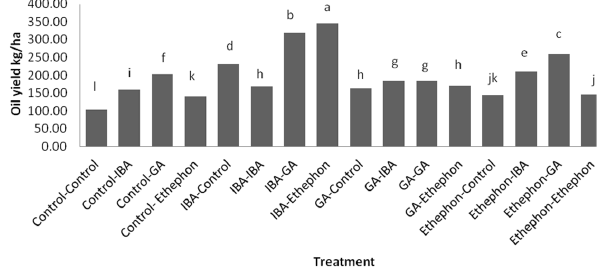
Fig. 3. Effect of PGRs on oil yield kg/ha in medicinal pumpkin ( Cucurbita pepo var . styriaca cv. ‘Kaki’) in farming